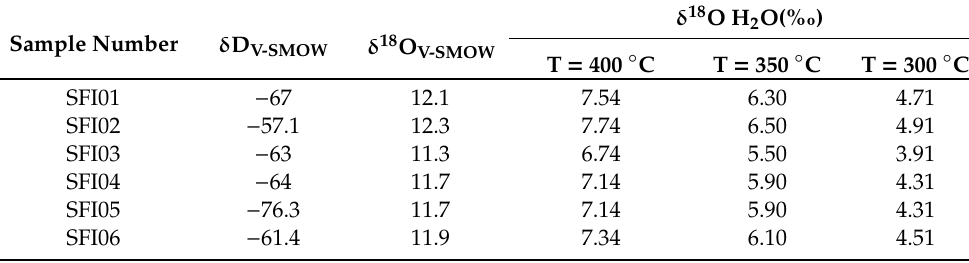
Table 3. Hydrogen and oxygen isotopic compositions of ore-bearing quartz from the Shangfang W deposit.